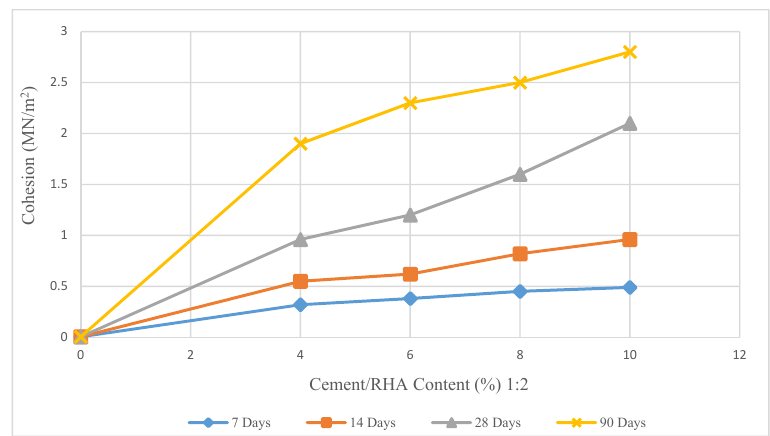
Figure 11. Effect of lime/RHA 1:2 content on cohesion. Materials 2021 , 14 , x FOR PEER REVIEW